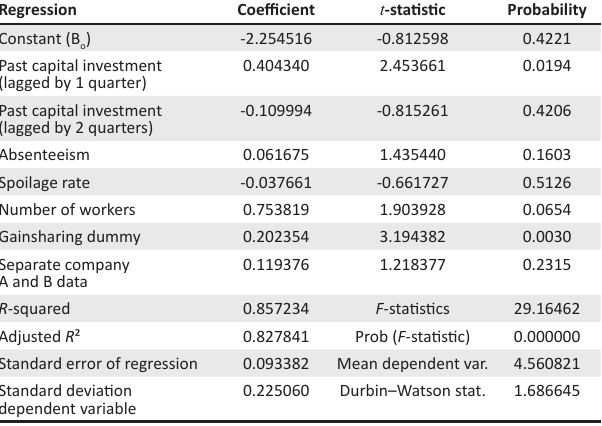
TABLE 7: Labour productivity results with capital investment lagged by 2 quarters.